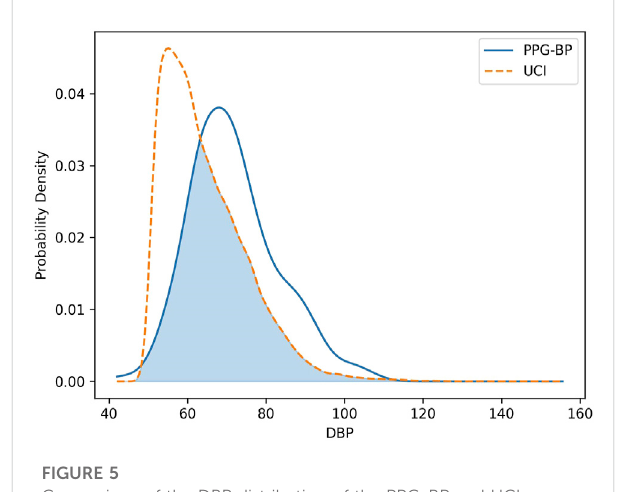
FIGURE 4 Comparison of the HR distribution for the PPG-BP and UCI datasets.